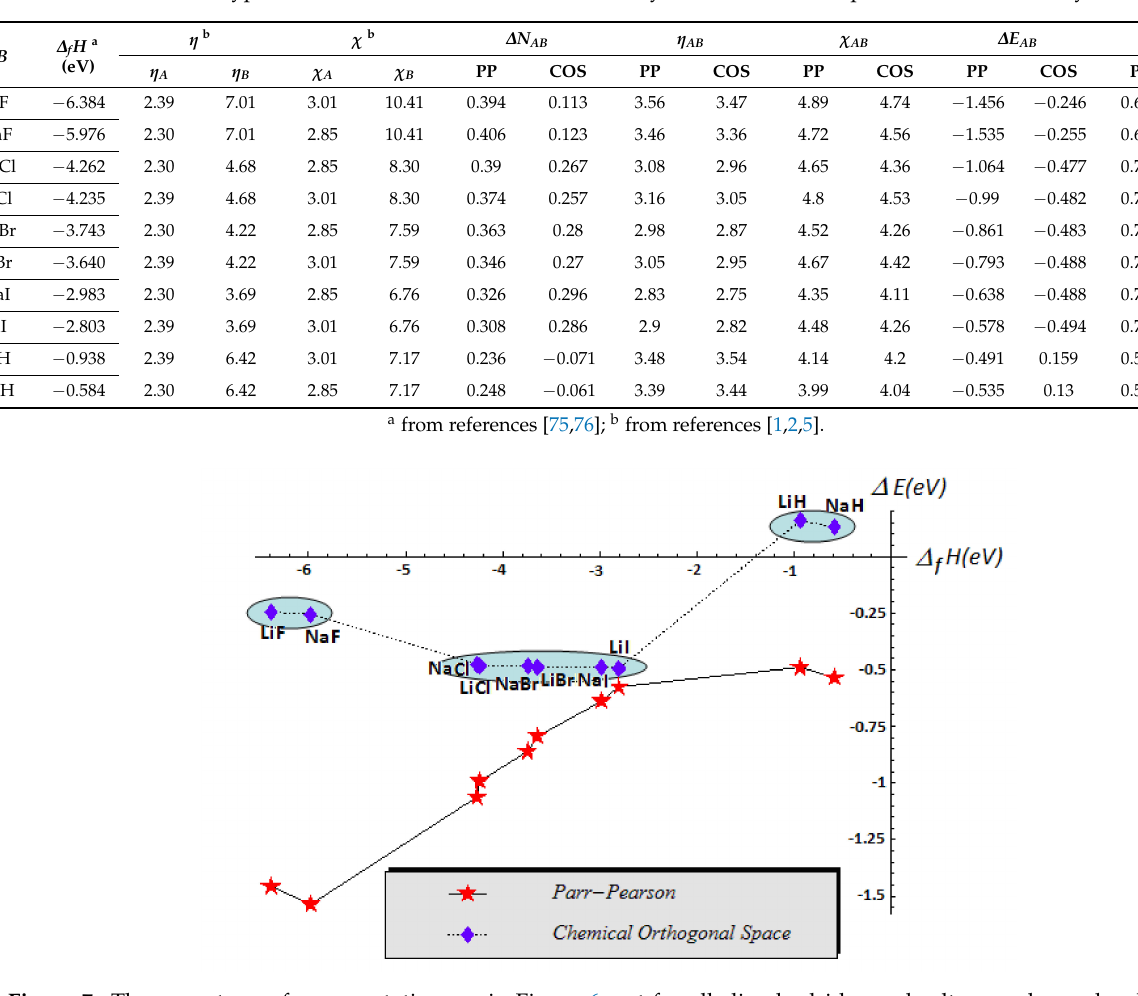
Figure 7. The same type of representations as in Figure 6, yet for alkaline hydrides and salts as polar molecules in a crystal